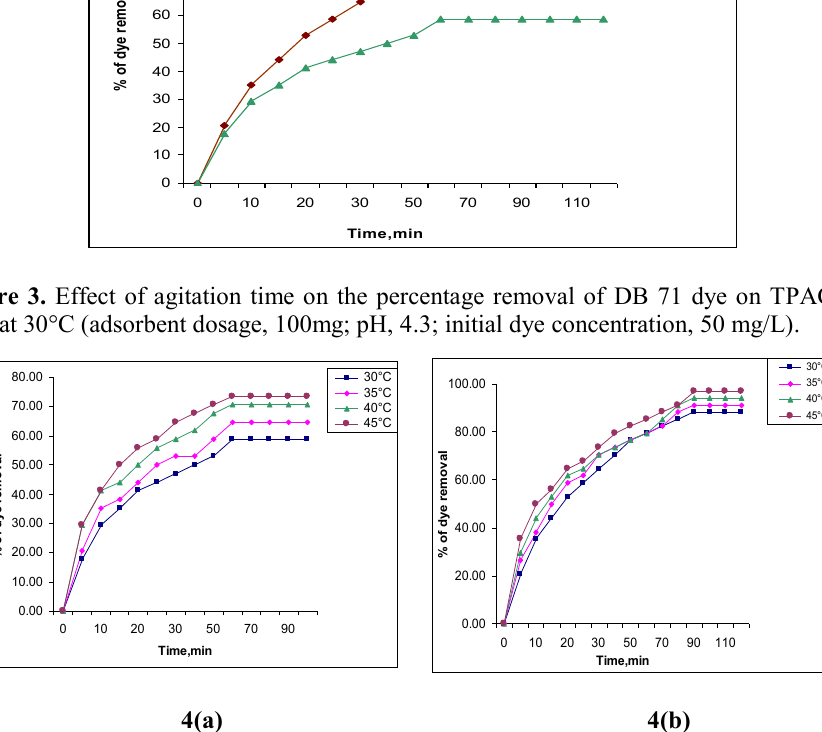
Figure 4. Effect of temperature on the adsorption of DB 71 dye on to TPAC and PPC at initial concentration of 50 mg/L (adsorbent dosage, 100mg; pH,